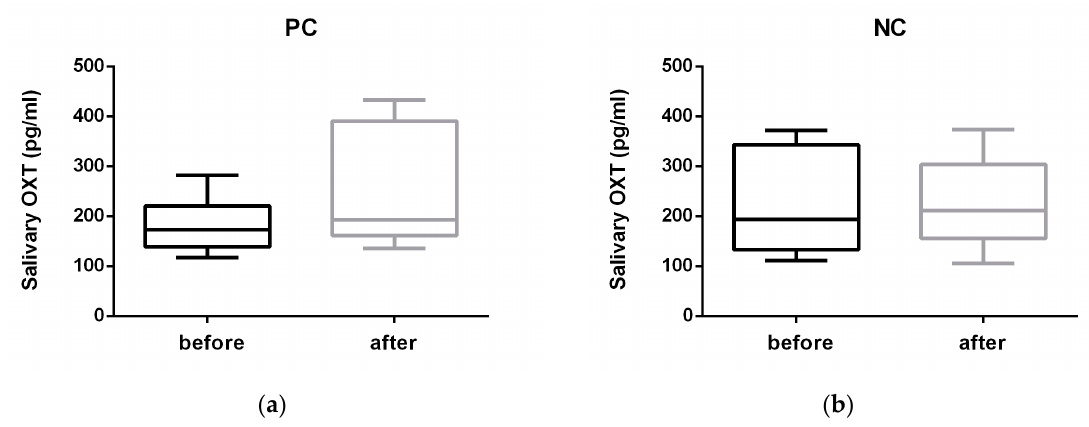
Figure 1. Salivary OXT (oxytocin) concentration (pg/mL) before and after ( a ) the positive condition consisting of 5 min of affiliative interaction between dogs and their trainers (PC) and ( b ) the negative condition consisting of 5 min of isolation (NC). Table 2. Frequency and relative duration of presented behavior during 5 min of isolation.